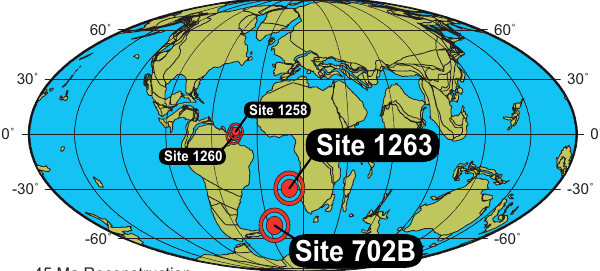
Figure 1. Location map for ODP Hole 702B and Site 1263 on a 45Ma paleogeographic reconstruction in Mollweide projection (from http://www.odsn.de); also given is the location of ODP Sites 1258 and